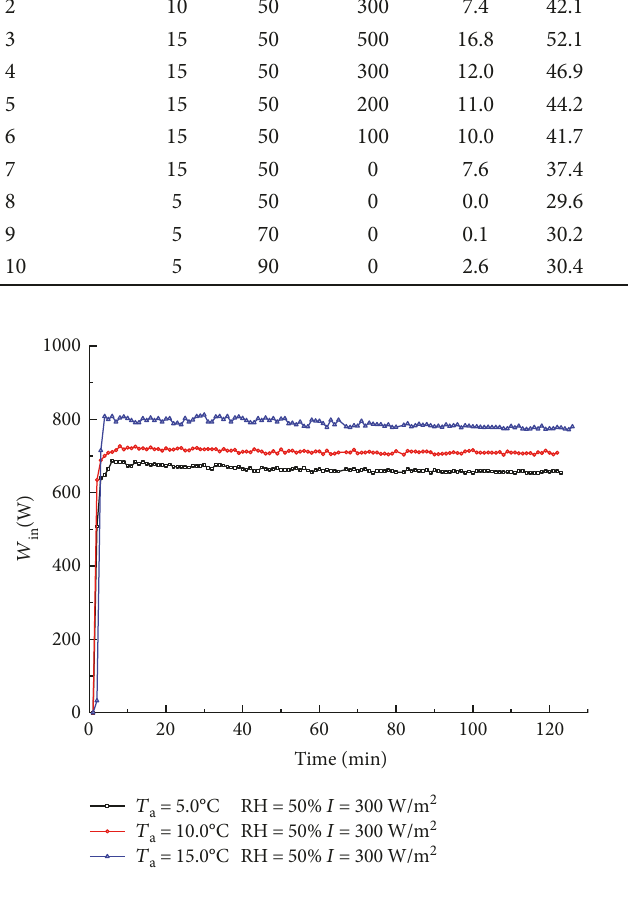
Figure 2: Variation of the energy consumption with the ambient temperature of 5 ° C, 10 ° C, and 15 ° C.